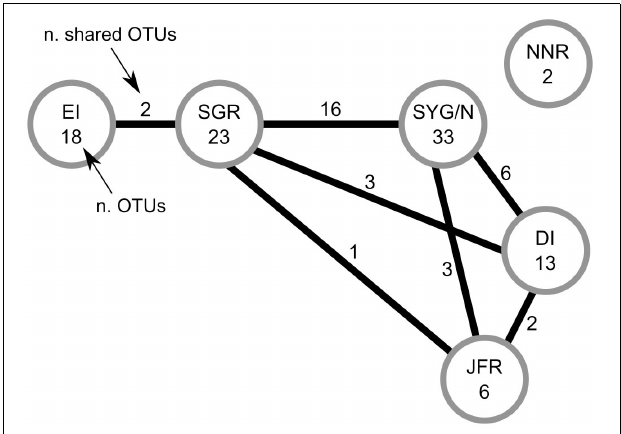
FIGURE 3 | Number of OTUs (operational taxonomic units; mostly species and genera, Table 2 ) observed in each area (number within the circles), and number of OTUs shared between areas (numbers on the